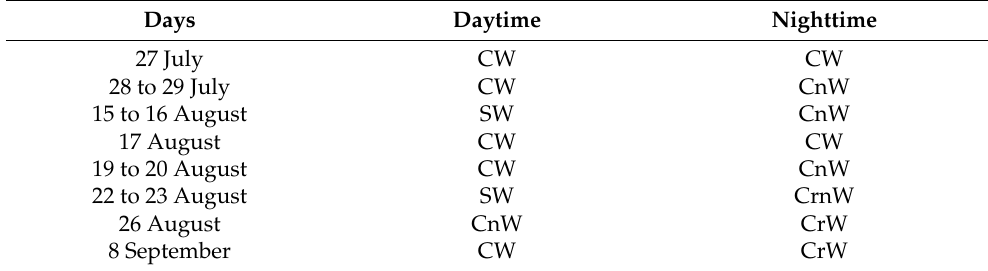
Table 5. Classification of the days studied during July to early September 2016. CW represents cloudy– windy period. CnW represents cloudy and not-windy period. CrW represents a clear and windy period. CrnW represents a clear and not-windy period. SW represents sunny and windy period. Days